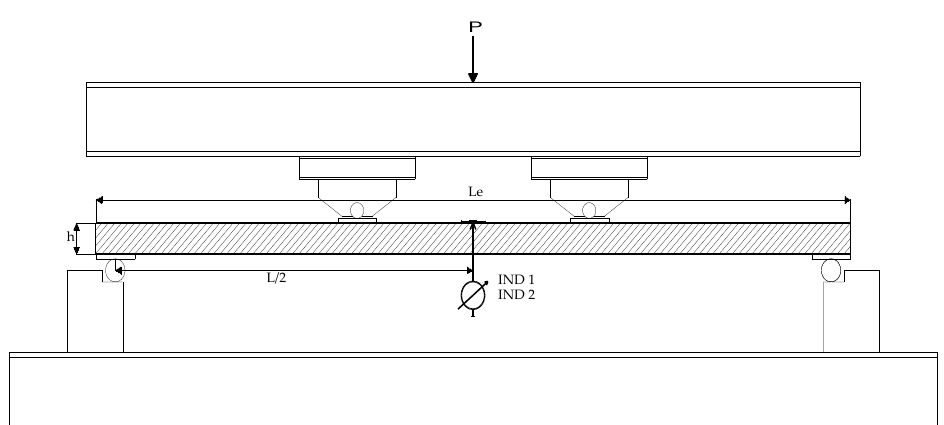
Figure 5. The testing equipment for the performance of the four-point bending tests. Forests 2018 , 9 , x FOR PEER REVIEW